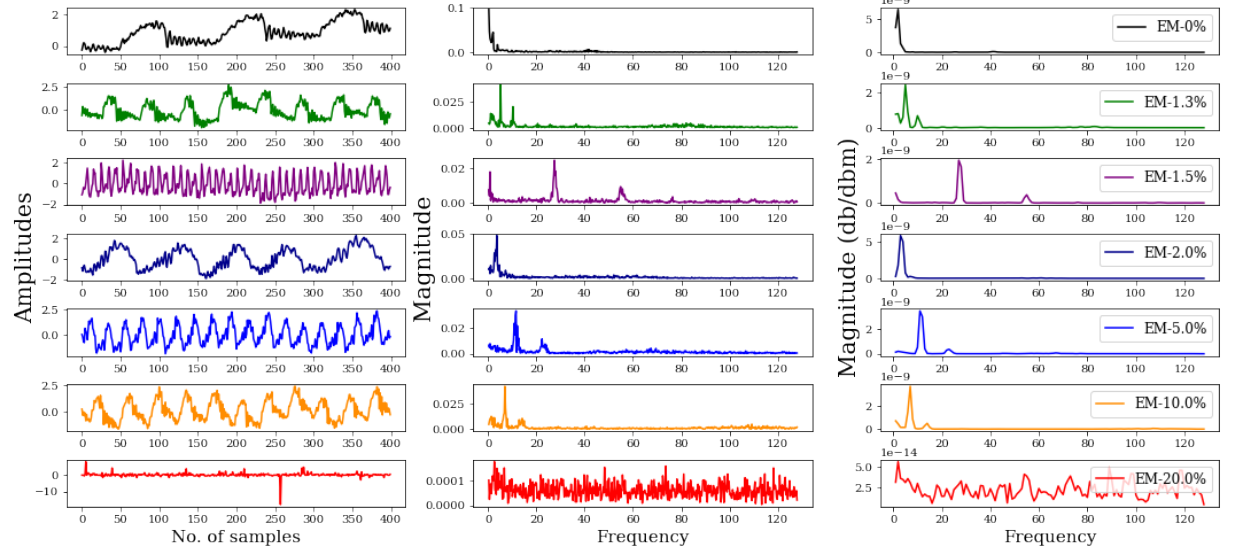
Figure A2. CR signals and their FFT and PSD outputs at 1200 RPM for the emulsion